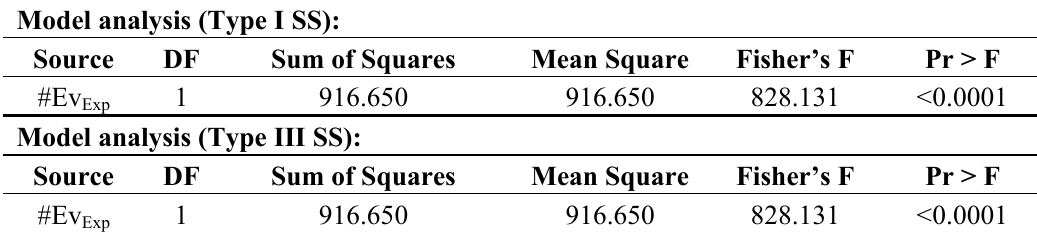
Table 14. ANOVA of the SIM_Exp_Lang variable.